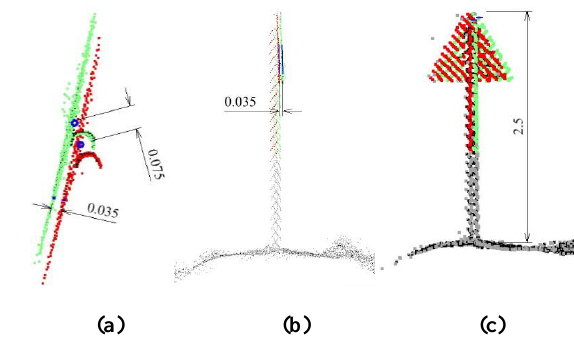
Figure 8 . Road sign before adjustment: ( а ) top view; (b) left view; (c) front view.